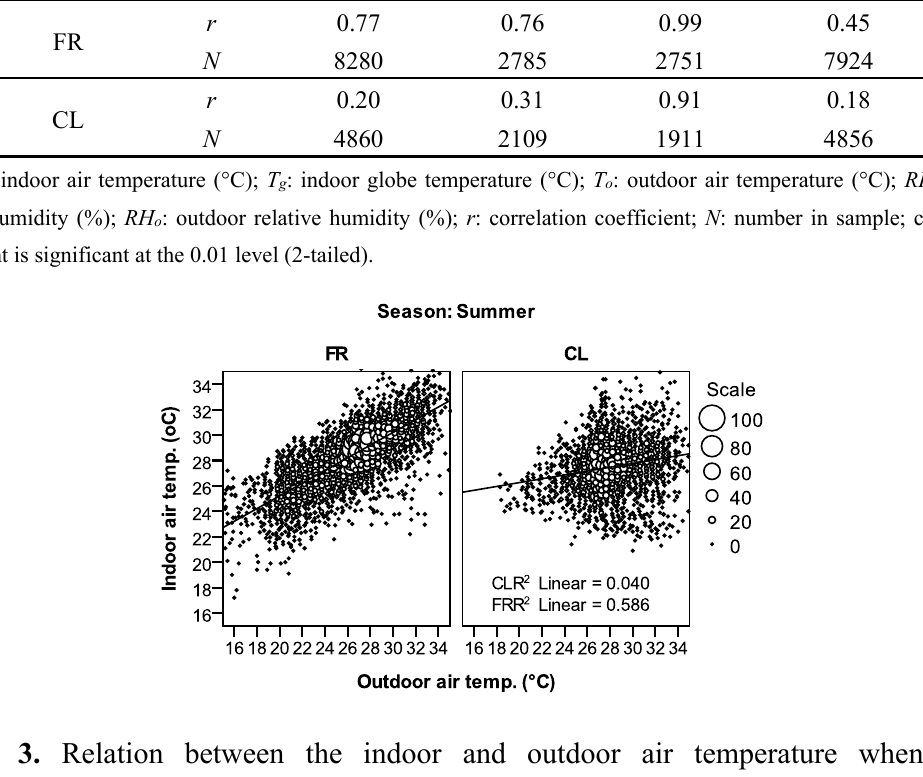
Figure 3. Relation between the indoor and outdoor air temperature when voted (all raw